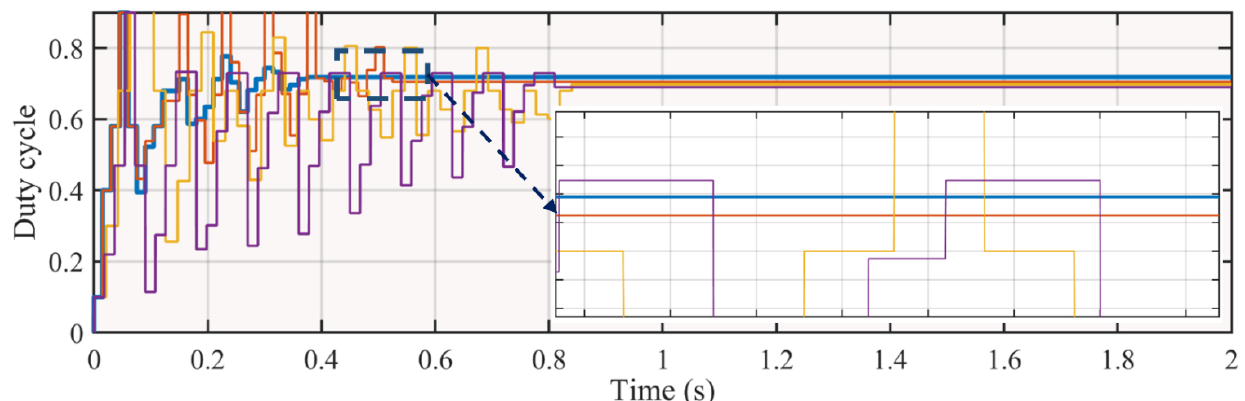
Figure 10. Competing techniques zoomed in duty cycle Case-1.